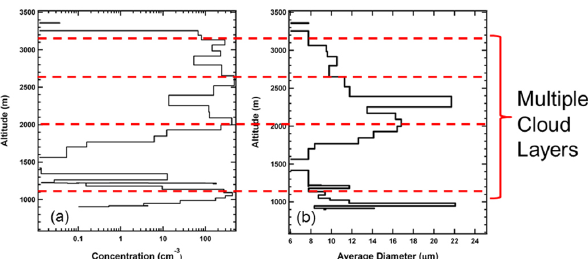
Figure 16. These vertical profiles of the number concentration in the left panel and average optical diameter in the right panel are an example of multilayered clouds (red horizontal lines) measured with the backscatter cloud probe as the aircraft was landing in Frankfurt, Germany in May, 2011. Cloud layers are delineated by the peaks in concentration greater than 100cm − 3